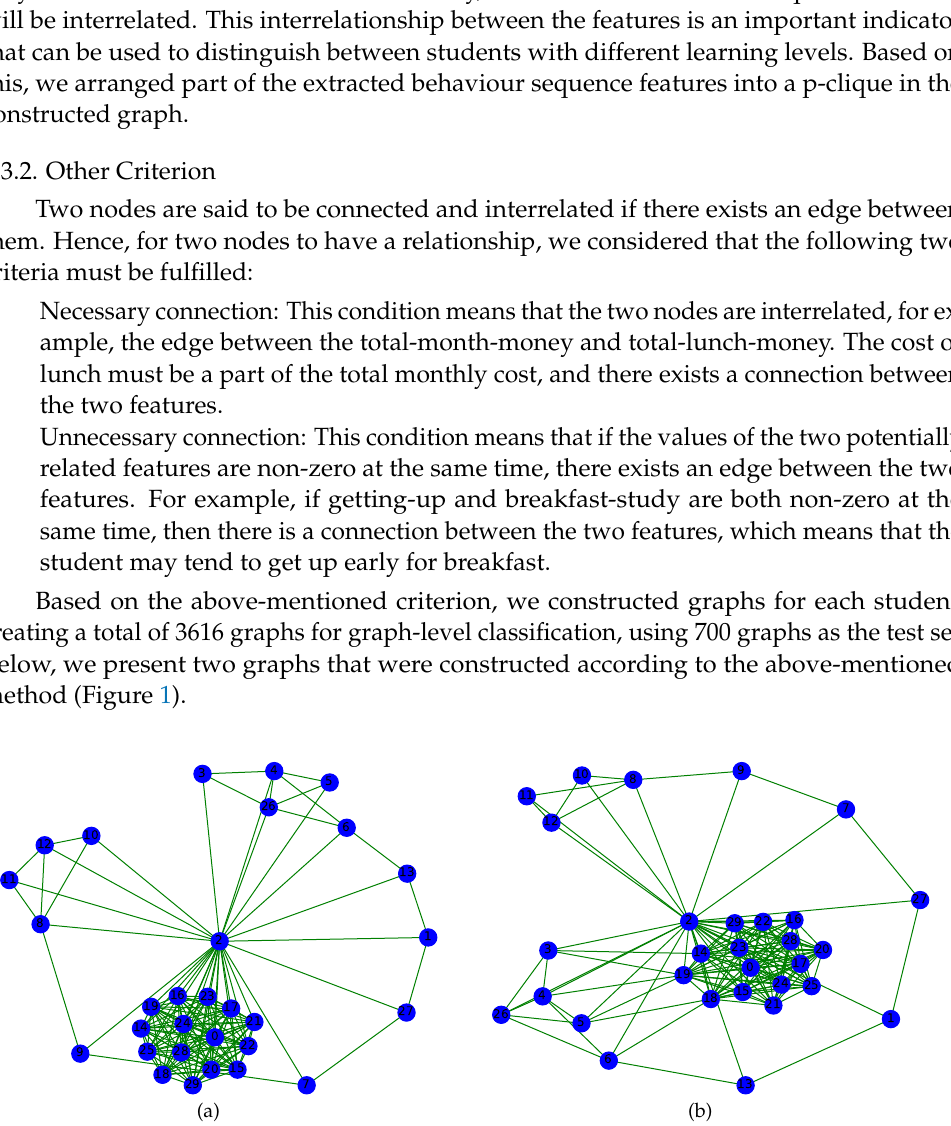
Figure 1. Different graph structures built for different students. The differences resulted from the students having different lifestyles. ( a ) Graph constructed for student with exam score 84.88 whose ID number equals 17347; ( b ) graph constructed for student with exam score 91.28 whose ID number equals